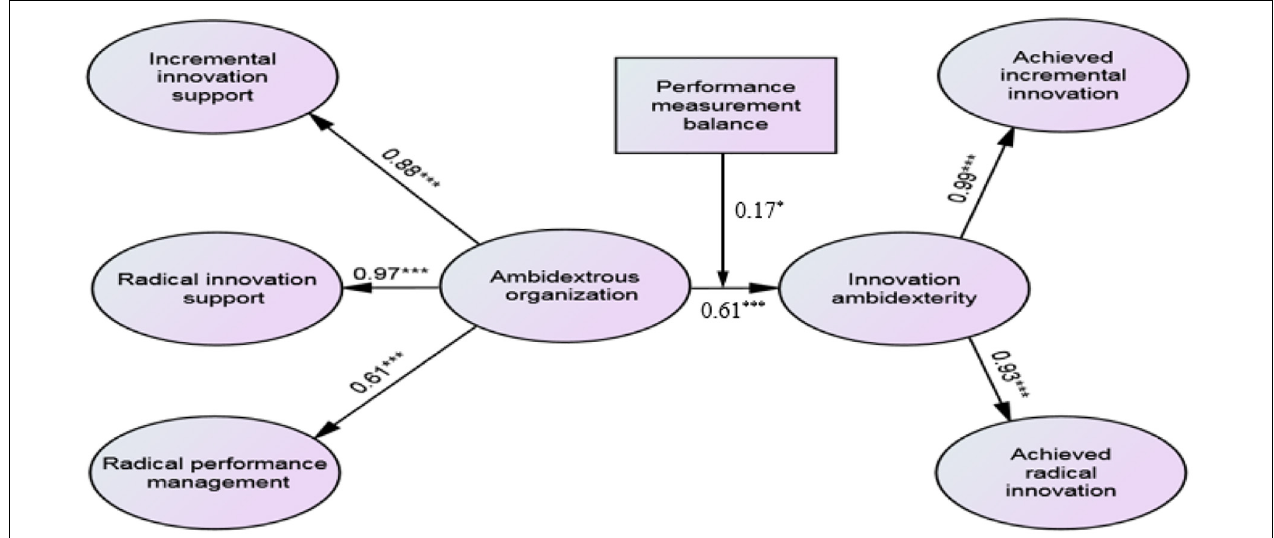
FIGURE 3 | Structural model with significant hypothesis relationships represented. *** Significant at the 0.001 level,* Significant at the 0.05 level (Two-tailed